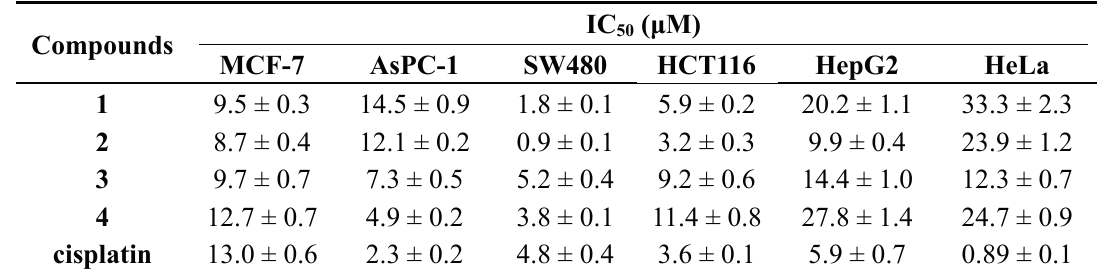
Table 2. Cytotoxicity of compounds 1 – 4 against cancer cell